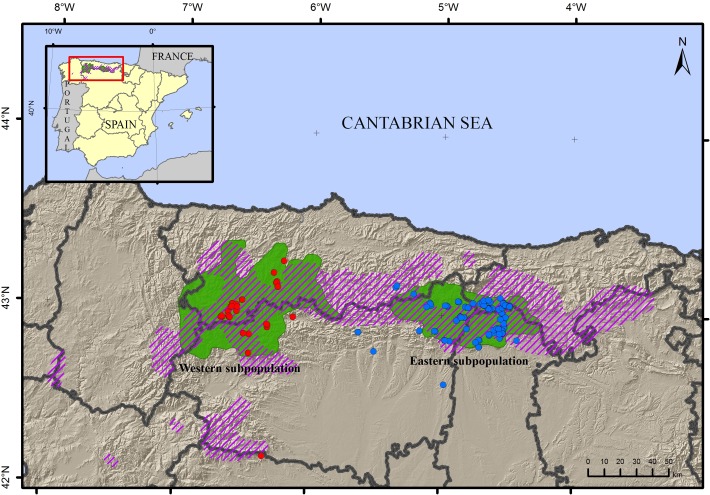
Map of the sampling locations of the brown bear Ursus arctos.Samples from the western subpopulation are in blue, samples from the eastern subpopulation are in red. The current distribution area (green) and approximate area of historical occupancy in the 19th century (dashed line) are also indicated.